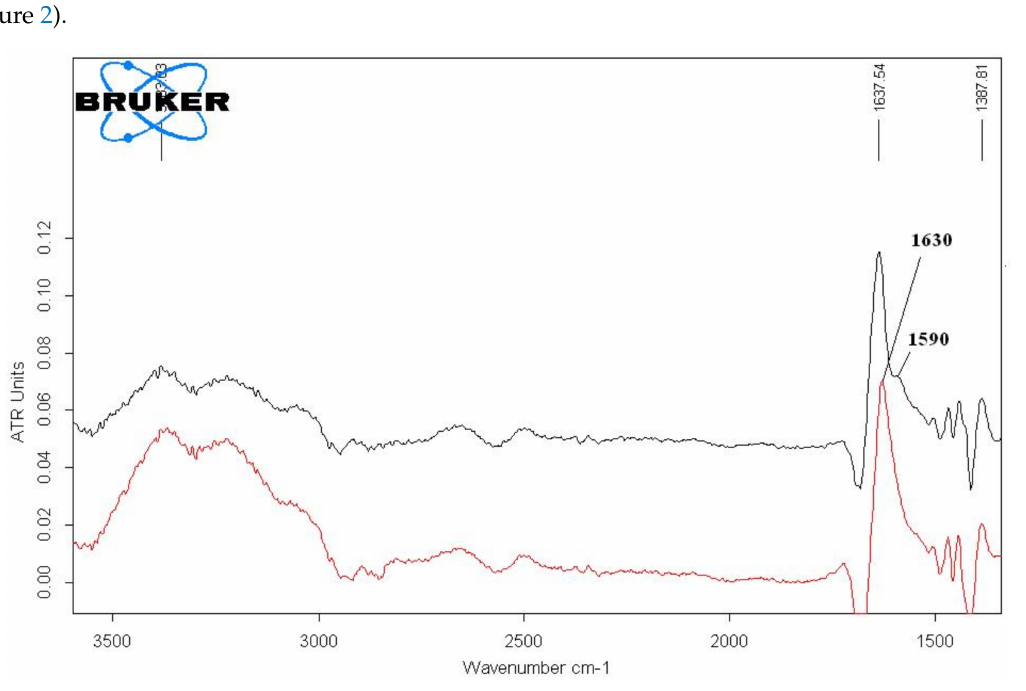
Figure 2. IR spectra of VP-VFA-VIDA (lower spectrum) and VP-VFA-VIDA–Ga metal-polymer complexes ((MPC (upper spectrum)) after subtraction of the initial copolymer